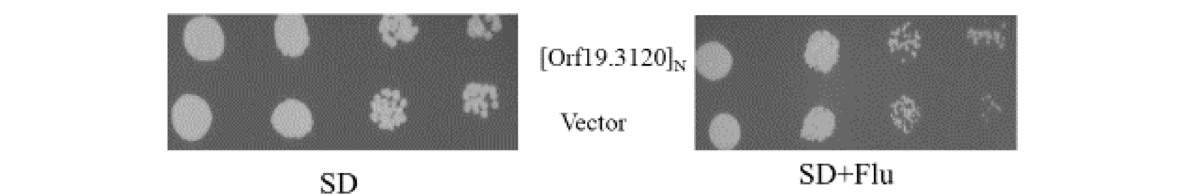
Fig. 8 Overexpression of Orf19.3120 and its response to fluconazole. Strains were 10-fold serially diluted and spotted on synthetic dextrose (SD), and synthetic dextrose plus fluconazole (8 μ g/ml) (SD+Flu) plates lacking uracil. The overexpressed strain grows a little better than the control strain in the presence of